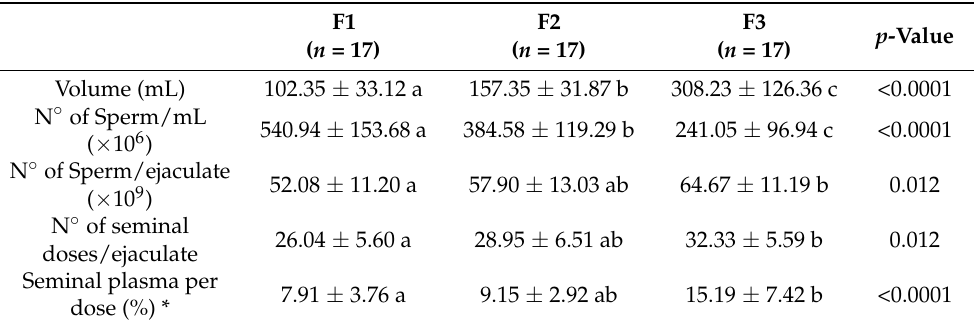
Table 1. Characteristics of the ejaculates from 6 boars used in the experiment. Data are represented as the mean ± SD (standard deviation).. The number of ejaculates evaluated per group (F1, F2, F3) is indicated between brackets.